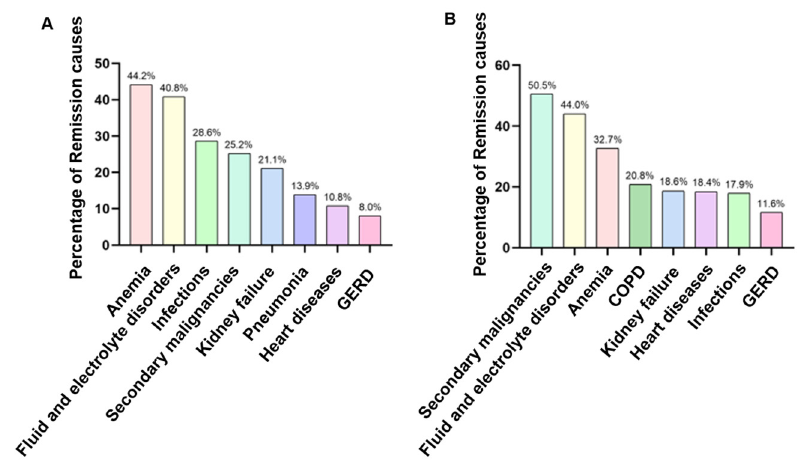
Figure 5. The 8 most common (tumor- and nontumor-related) causes of 30-day UPRs in colorectal cancer, lung cancer, non-Hodgkin lymphoma, prostate cancer and stomach cancer patients with IDDs ( A ) or without IDDs ( B ) (based on ICD-10-CM codes). Table 3. Difference analysis of the 30-day unplanned readmission causes in IDD and NOIDD patients. Causes of UPR, n